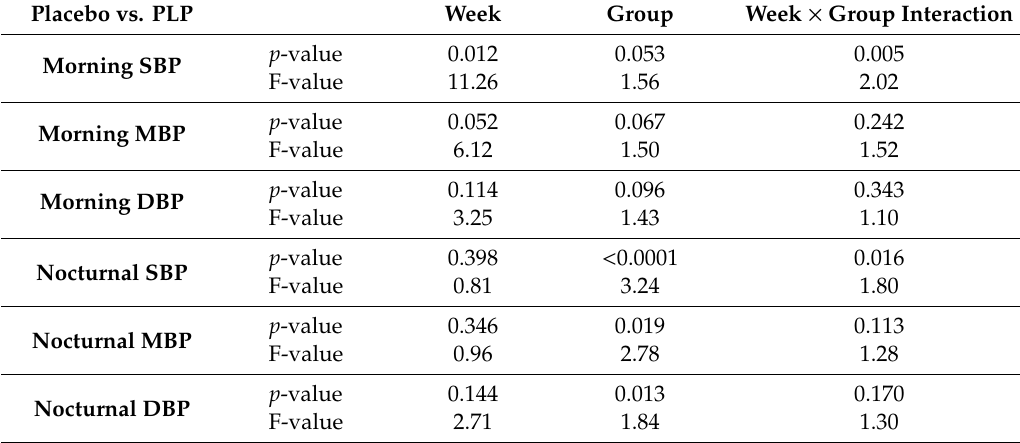
Table 3. Results of two-factor analysis of variance (ANOVA) on morning systolic blood pressure (SBP), MBP, and nocturnal DBP data obtained in the placebo and Perilla frutescens leaf powder-intake subjects with home SBP ≥ 120. Data are presented in Figure 1. SBP, systolic blood pressure; MBP, mean blood